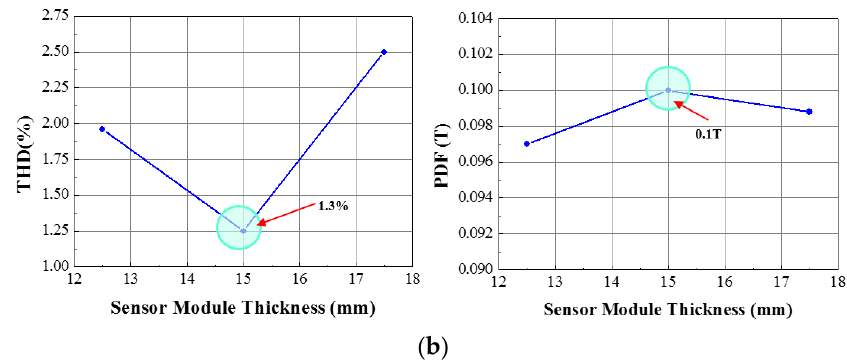
Figure 10. ( a ) 3D configuration of the sensor module and Flux Density variation with thickness; ( b ) Effect of sensor thickness variation on PFD and THD.